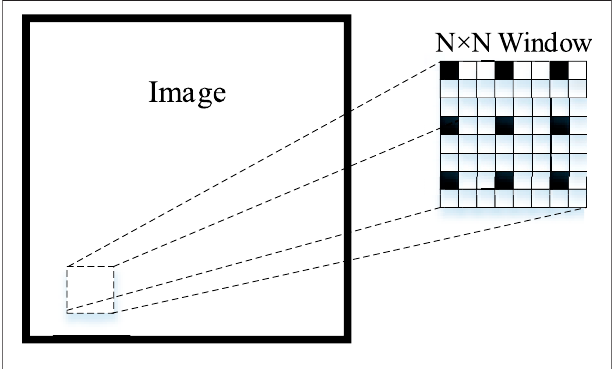
FIGURE 3 | Lucas-Kanade method: estimate the optical fl ow of black